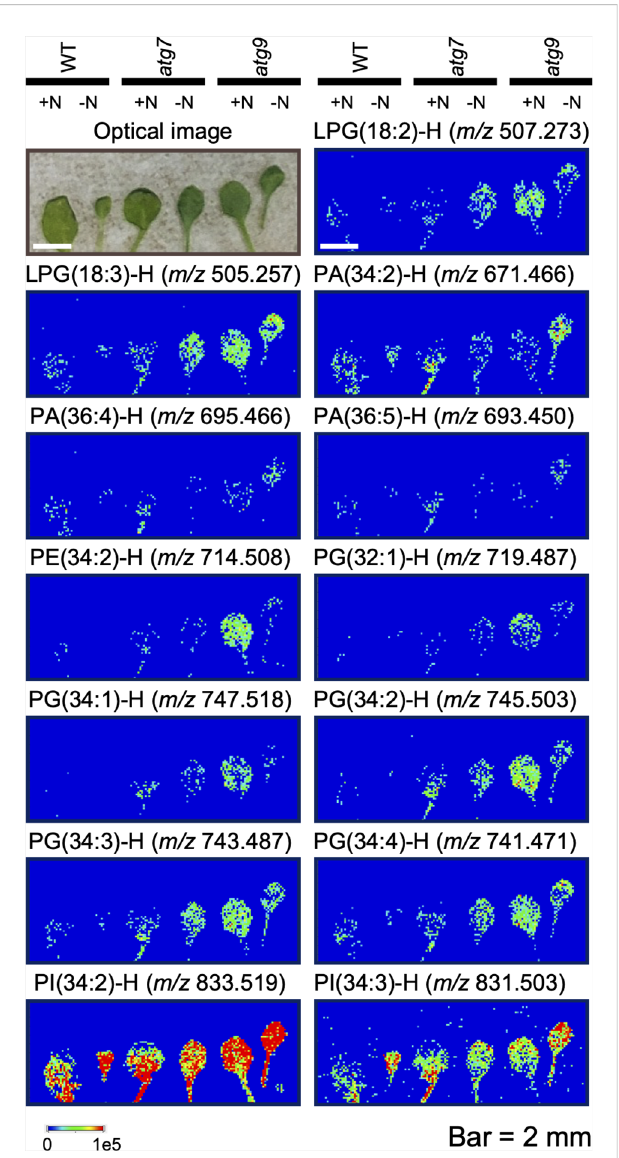
FIGURE 5 Mass spectrometric imaging of the spatial distribution of speci fi c phospholipids in WT, atg7 and atg9 mutant leaves. One of the fi rst pair of true leaves from plants grown in either (+N) or (-N) treatment of the indicated genotypes were used in these imaging experiments. Leaves were longitudinally fractured to reveal the leaf interior, and this exposed surface was imaged optically or by mass-spectrometry. All mass-spectrometric images detected the deprotonated ion ([M − H] − ) of the indicated phospholipid molecular species in negative mode using 1,5-diaminonaphthalene (DAN) as the matrix. The colored scale bar shows the relative intensities within a sample. The ion signals were normalized to the total ion count and the maximum values of 1x10 5 was used for all the